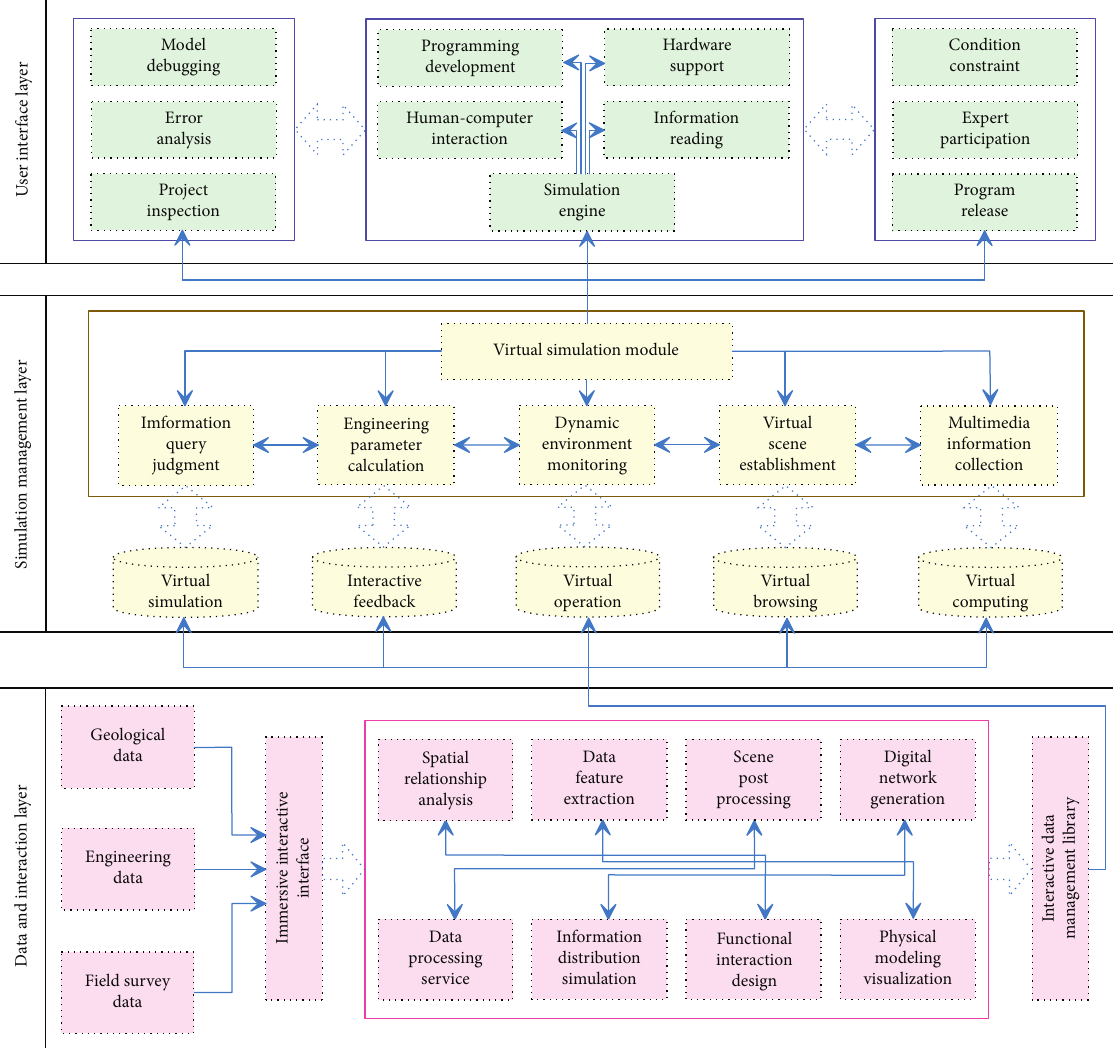
Figure 2: Framework and structure of virtual reality platform